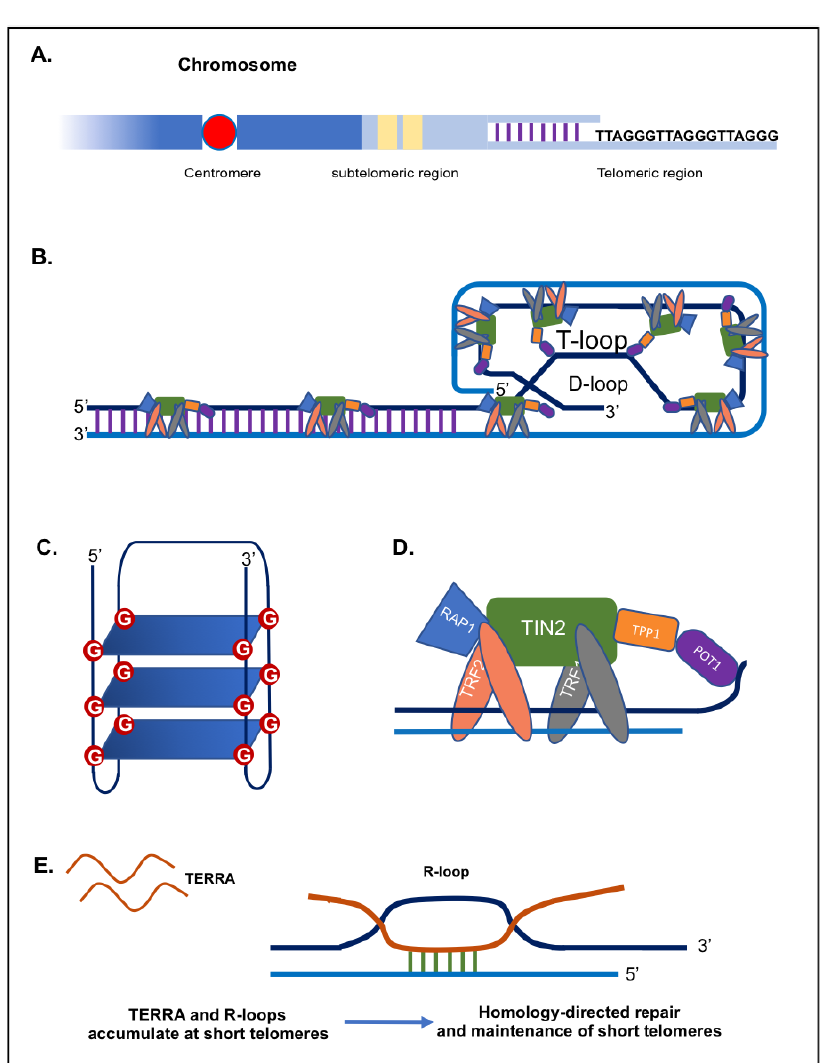
Figure 1. Telomeric DNA, proteins and TERRA. ( A ) Schematic representation of a telomeric region. ( B ) T-loop and D-loop configurations, along with the Shelterin proteins. ( C ) G-quadruplex structure. ( D ) The shelterin complex including the following proteins Telomeric-Repeat-binding Factor 1 and 2 (TRF1 and TRF2), Protection of Telomeres 1 (POT1), TRF1-Interacting Nuclear protein 2 (TIN2), TIN2-interacting protein (TPP1), and Repressor-Activator Protein 1 (RAP1). ( E ) TERRA and R-loops.